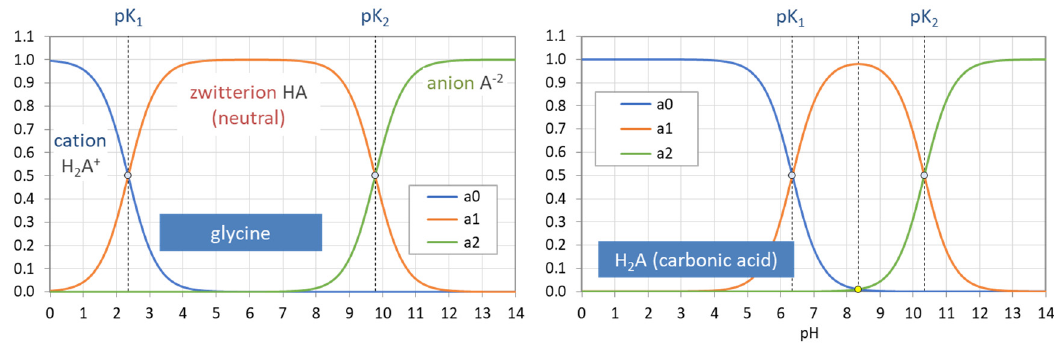
Figure 34. Ionization fractions of two diprotic acids: glycine ( left ) vs. carbonic acid ( right ).